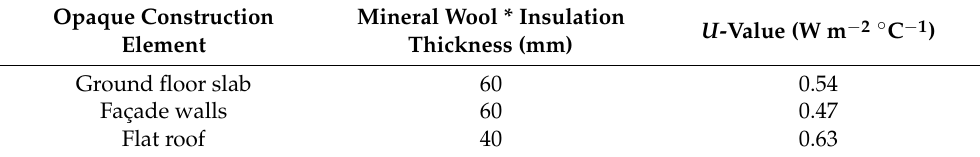
Table 2. Insulation thickness and U -value of the envelope construction solutions. Opaque